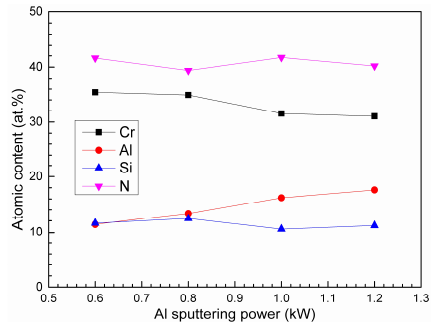
Figure 1. Chemical compositions of the four CrAlSiN coatings deposited under di ff erent Al sputtering power.